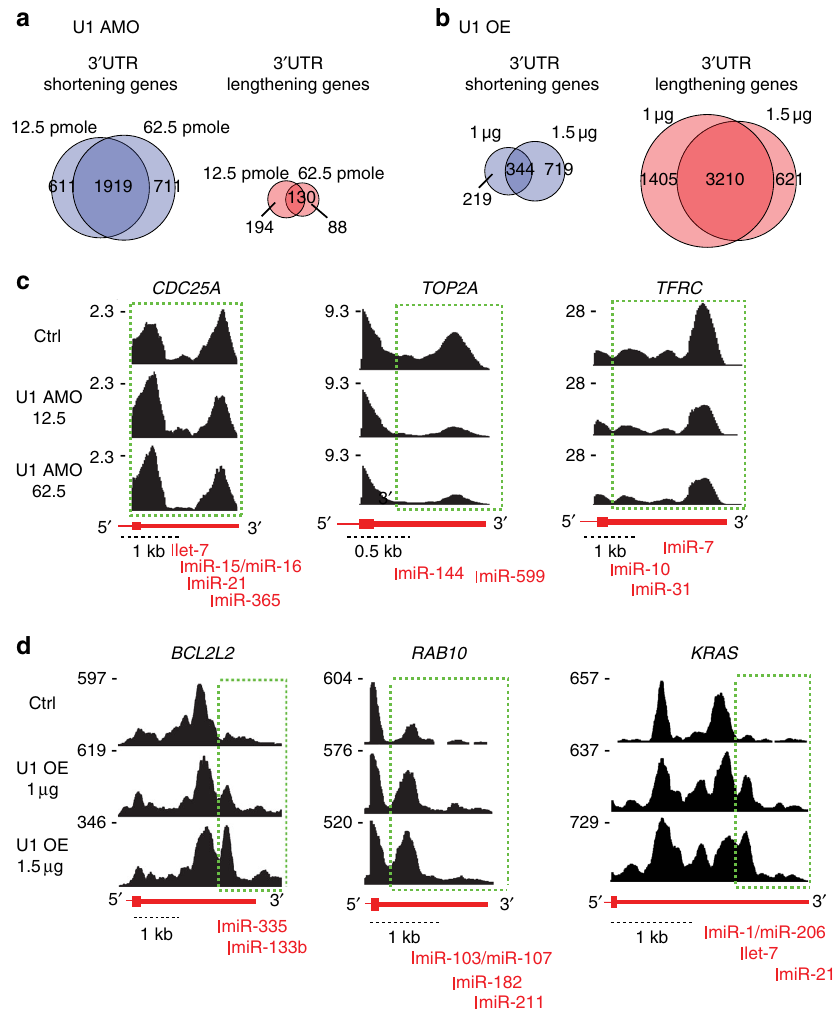
Fig. 3 Examples of genes with 3 ’ UTR shortening by U1 AMO and genes with 3 ’ UTR lengthening from U1 over-expression. Venn diagrams of LECDS- identi fi ed genes affected by 3 ʹ UTR shortening versus 3 ʹ UTR lengthening in U1 AMO 12.5 and 62.5 pmole ( a ) and U1 OE 1 and 1.5 µ g ( b ) samples. c Cells transfected with control or U1 AMO (12.5 and 62.5 pmole, 8 h) were labeled with 4-thiouridine to select and sequence nascent transcripts. RNA-seq maps of representative genes from two biological experiments are shown. Green dotted boxes indicate the affected regions where shortening in the 3 ʹ UTR occurs. d Cells transfected with control or U1 expression plasmids (1 µ g and 1.5 µ g, 24 h) were labeled with 4-thiouridine to select nascent transcripts. Green dotted boxes indicate the regions where there was a switch towards longer 3 ʹ UTRs. miRNA target sites that are involved in cancer and expressed in HeLa